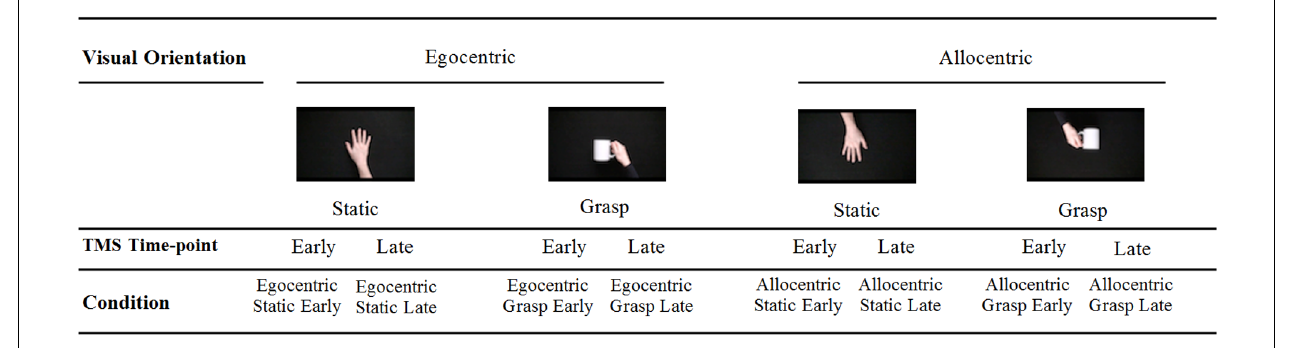
FIGURE 1 | Stimuli presented duringTMS